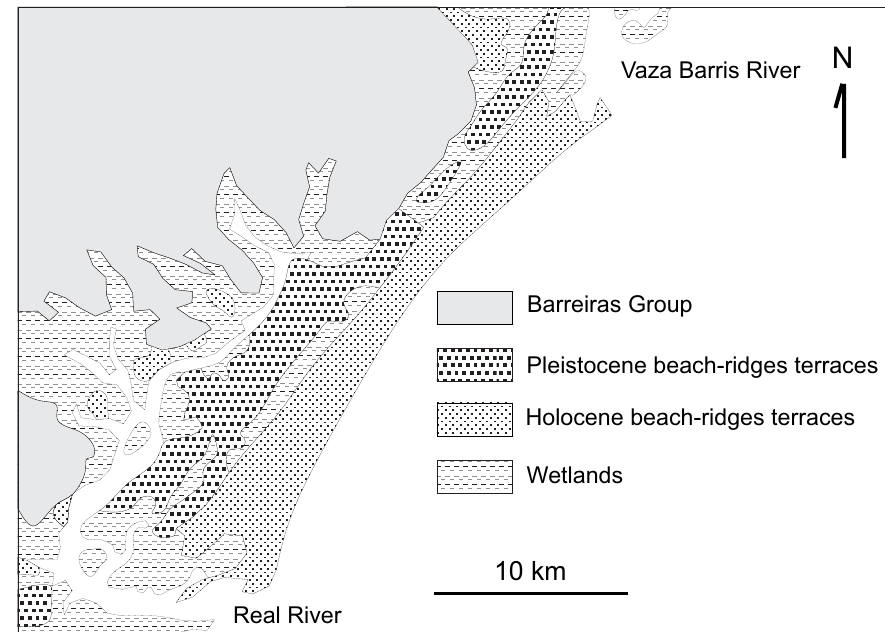
Fig. 7 – Simplified geological map of the coastal plain between Real and Vaza-Barris rivers illus- trating the persistence of the sediment dispersion and accumulation patterns during the Quaternary Period (After Dominguez et al.